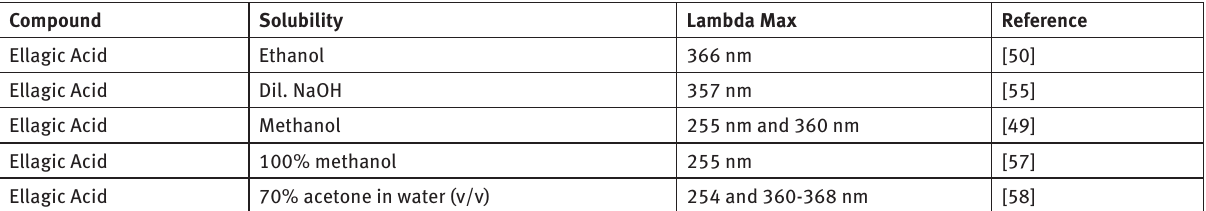
Table 1 Lambda Max of ellagic acid with different solvent systems by UV Spectrophotometry